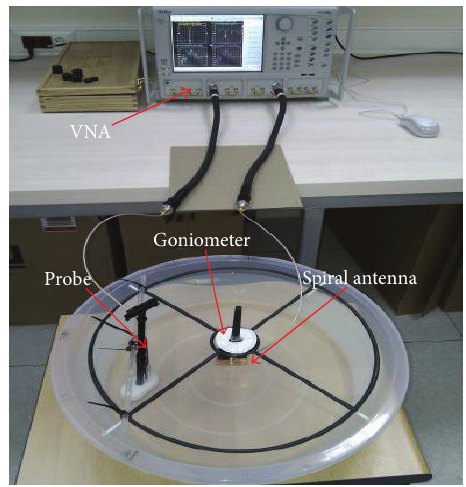
Figure 4: Measurement setup for manual radiation pattern mea- surements.